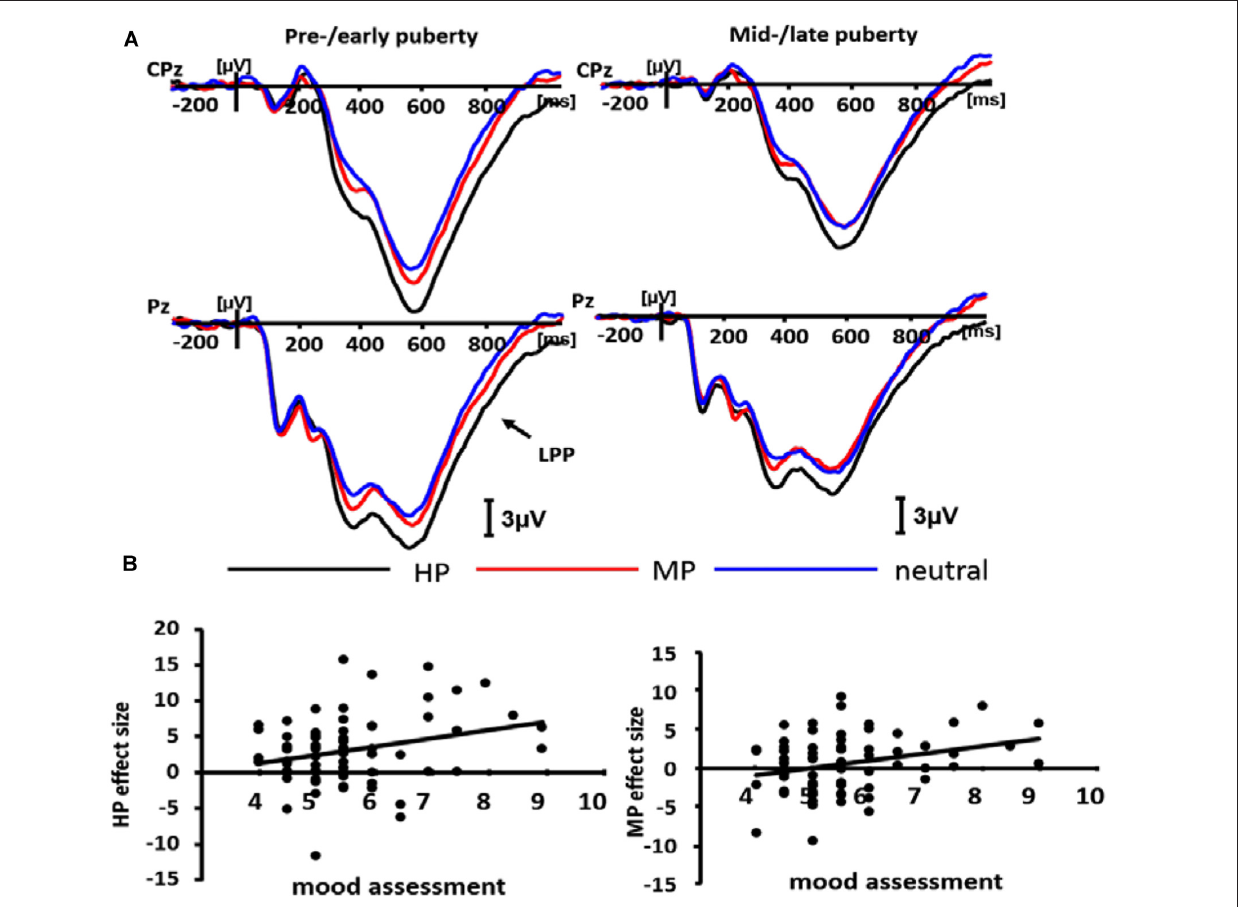
FIGURE 5 | Averaged ERPs for pre-/early and mid-/late pubertal sample during highly positive (HP; black lines), mildly positive (MP; red lines) and neutral (blue lines) conditions in the positive block (A) , and the scatterplot for the correlation between the emotion effect for HP, MP stimuli and mood assessment data (B) .